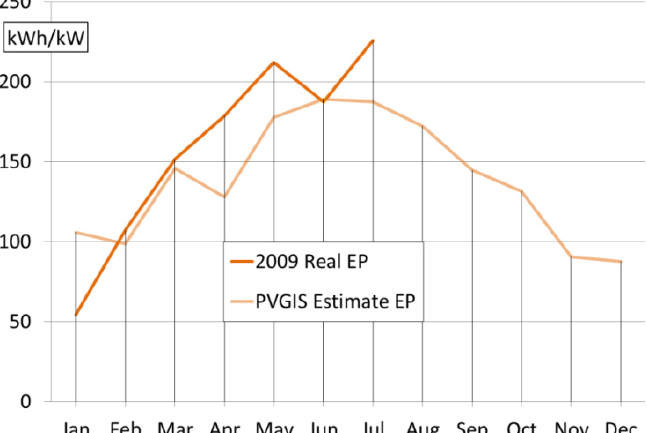
Figure 4. Real EP in 2009 and monthly EP estimate from PVGIS for the Écija CPV